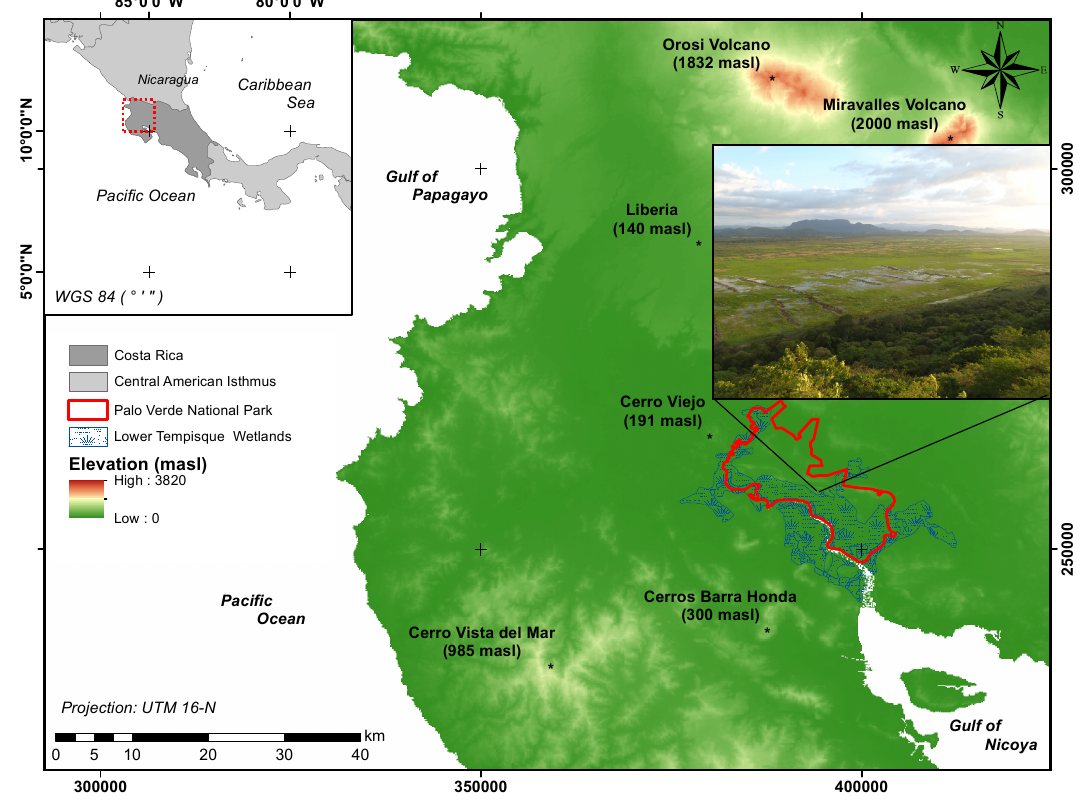
Figure 1. Geographical location of Palo Verde National Park in the Pacific North–West of Costa Rica. The photograph in the map shows the result of mechanical management activities within the lagoon with the consequently vegetation growth on the open water surfaces (GIS data source: Ortiz-Malavassi [49]).